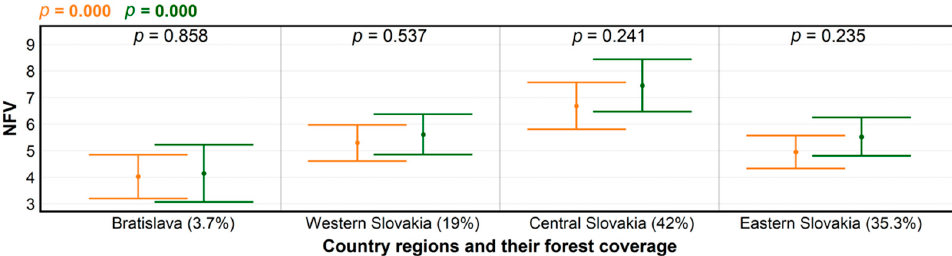
Figure 2. Levels of significance for differences in numbers of forest visits (NFV) per month according to regions characterized by forest coverage (%), before (orange) and during the COVID-19 pandemic (green), produced using ANOVA; and for NFV differences within groups (black), determined by t -test.